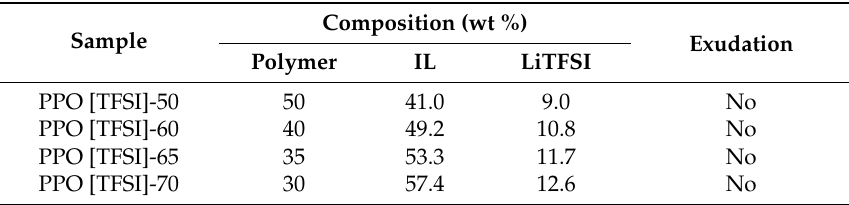
Table 4. Name and composition of different gelled